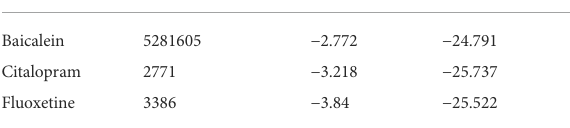
TABLE 3 Docking analysis of ligands against SERT (PDB ID: 5I73).